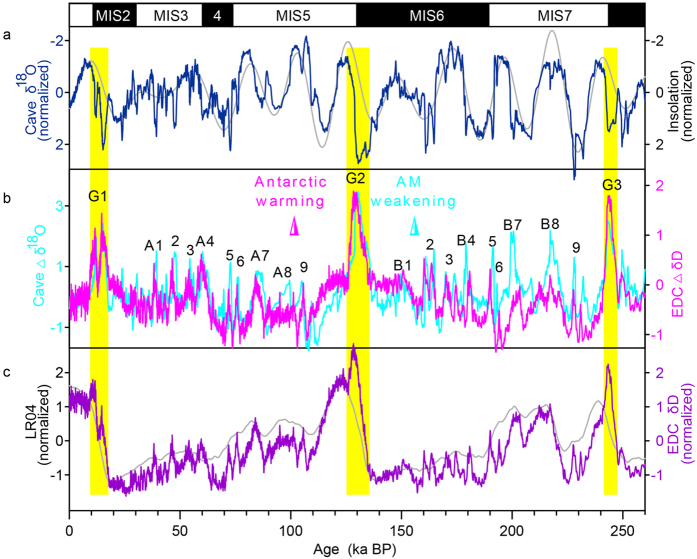
A link between orbital and millennial variability.(a) Composite Chinese cave δ18O record (normalized; navy blue), and the summer (21 July) insolation at 65°N (normalized; grey). (b) Detrended cave δ18O record (Δδ18O; cyan) and detrended EDC δD record (ΔδD; magenta). (c) Antarctic EDC δD record2 on the AICC2012 chronology22 (normalized; purple) and the LR04 marine stack21 (normalized; grey). A1-10 and B1-10 label the Antarctic warming events. Giant events at Terminations (G1-3) are marked with yellow bars.